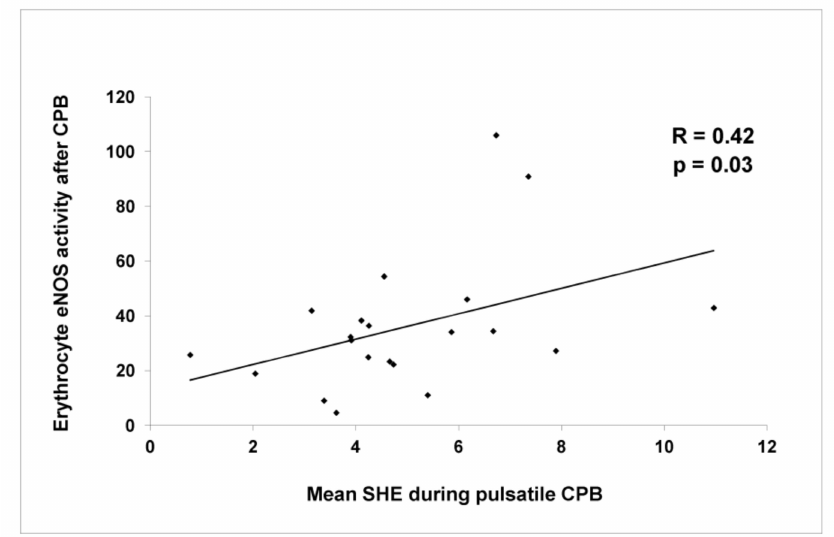
Figure 5. Diagrams of erythrocyte NOS activity during pulsatile and surplus hemodynamic energy